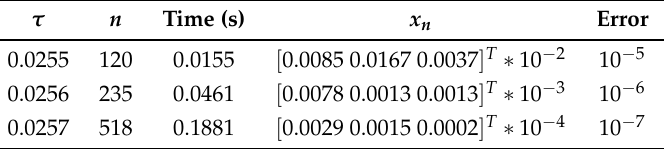
Table 5. x 0 = 10 ∗ rand ( 3,1 ) , results without bounded perturbation.